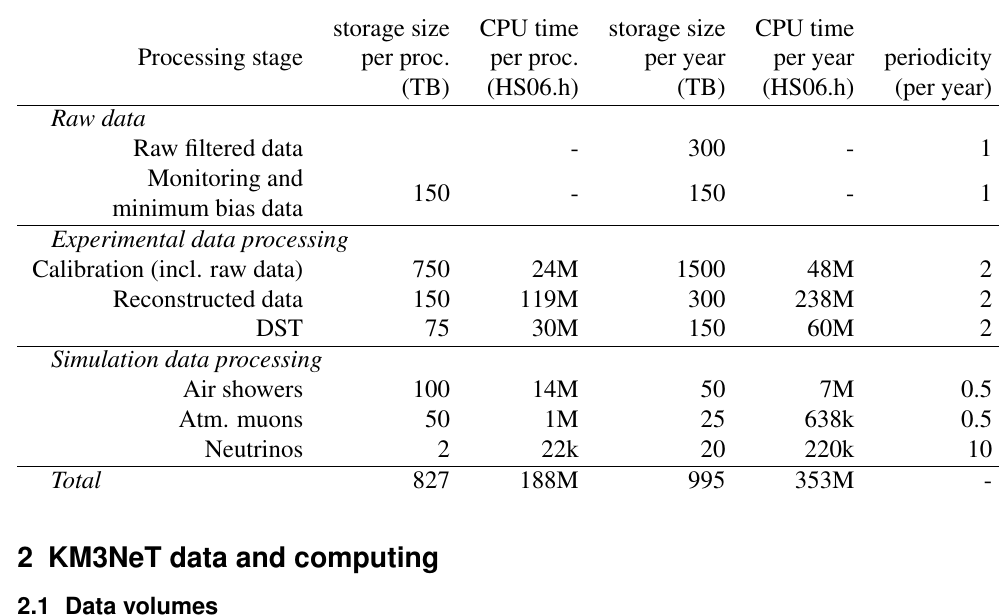
Table 1. Expected storage and computing time requirements for one building block (per processing and per year). The total storage size is without saving intermediate data processing steps, see